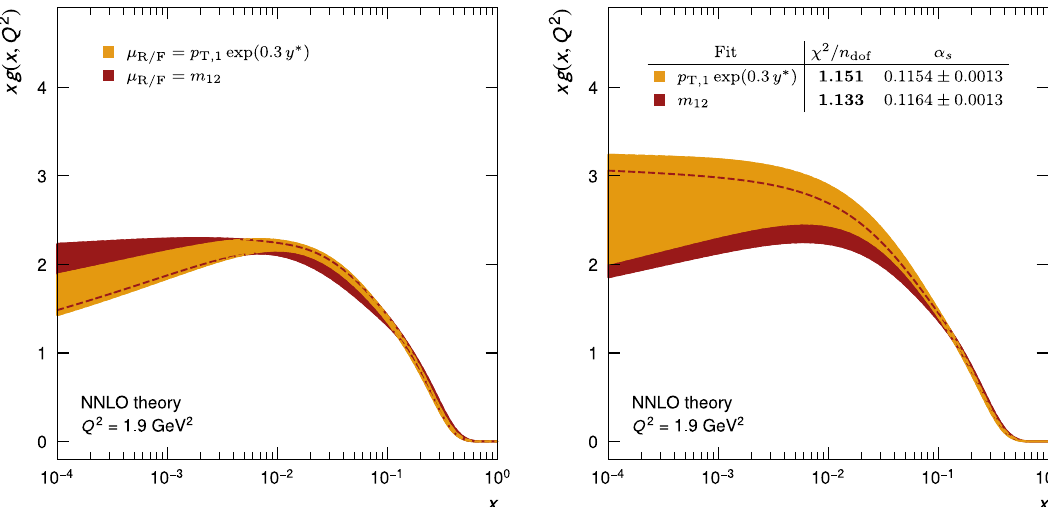
Fig. 10 Fits at NNLO of the gluon PDF using HERA DIS and CMS dijet data, but with uncertainties including scale variations (left) as described in the text, or with α s ( M Z ) as an additional parameter (right) Table 3 Values of α s ( M Z ) determined in the (13+1)-parameter PDF+ α s ( M Z ) fit at NLO and at NNLO with HERA DIS and CMS triple-differential dijet data, as described in the